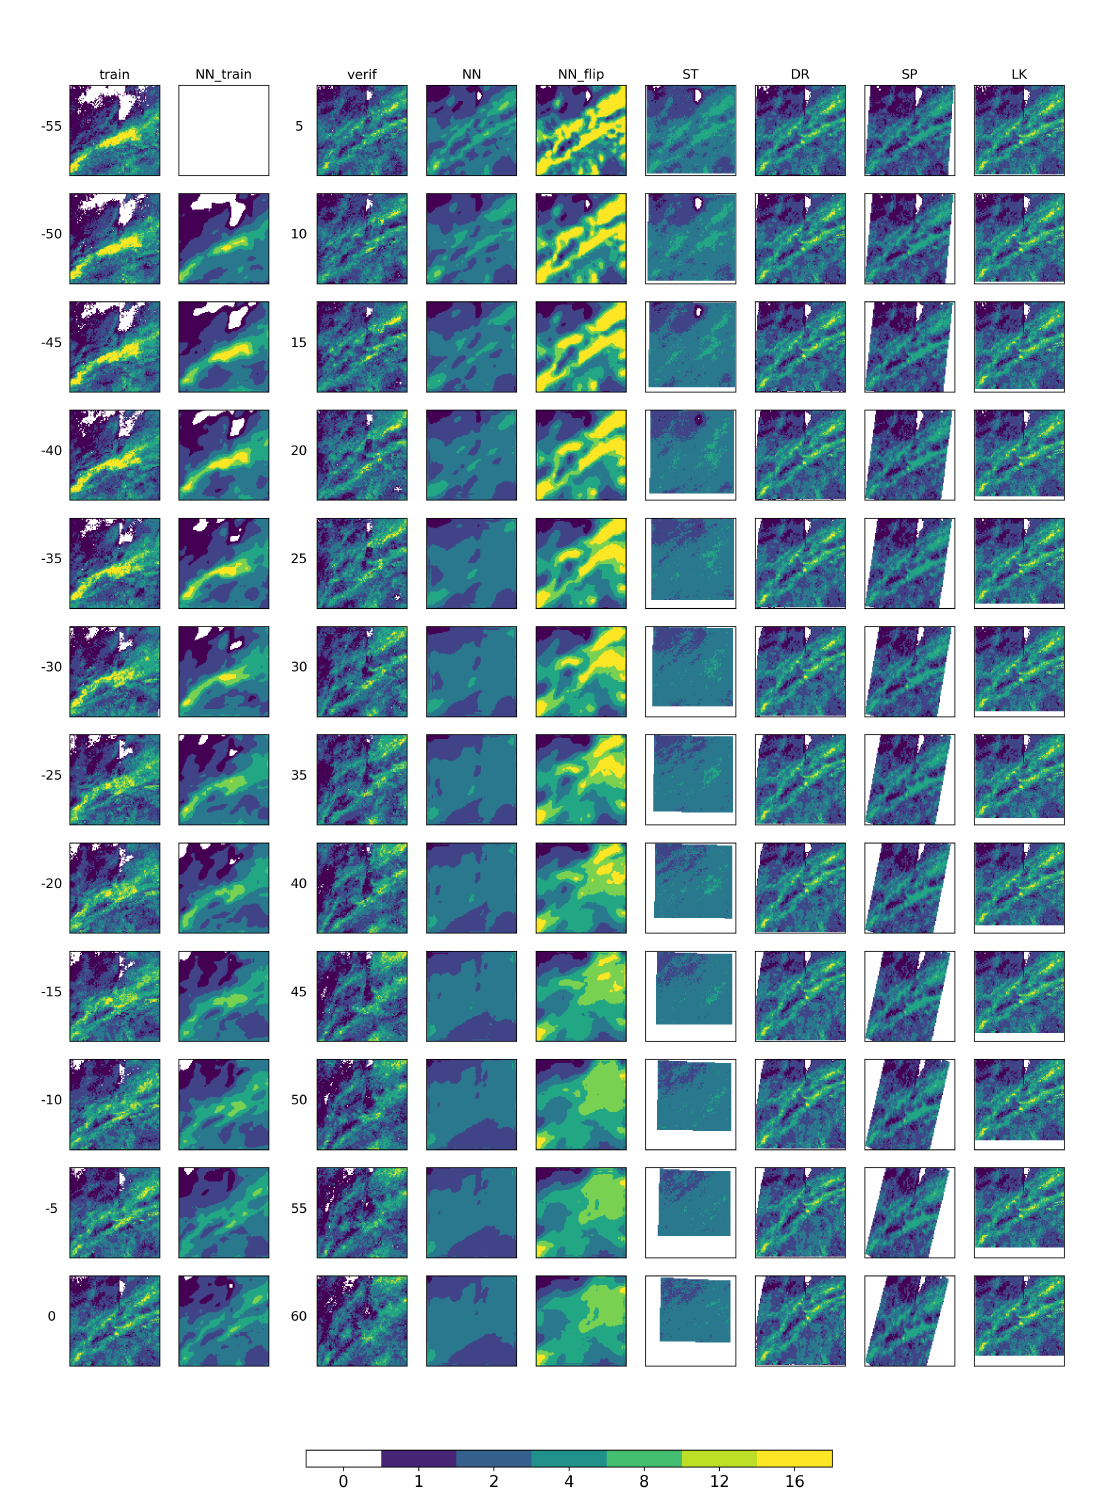
Figure 5. Frame sequence illustrating the mode of operation of the different nowcast techniques calculated for the one-hour forecast starting on January 8 at 16:25 UTM. See the text for a detailed description of the